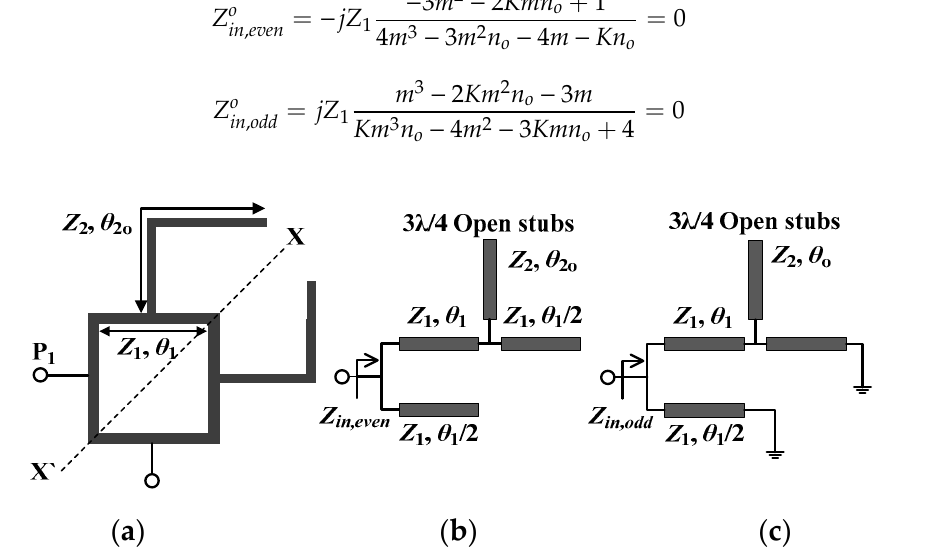
Figure 3. ( a ) Square ring resonator with 3 λ g / 4 open-ended stubs, ( b ) Even-mode equivalent circuit, ( c ) Odd-mode equivalent circuit.